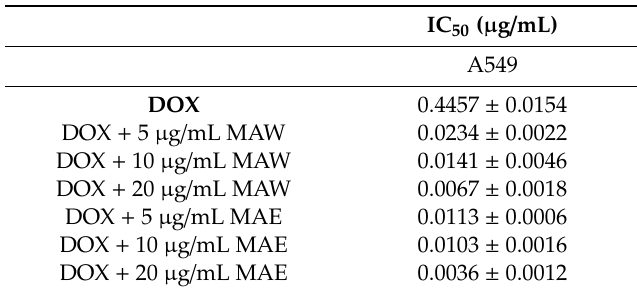
Table 1. Concentrations of doxorubicin alone or in combination with extracts that induced 50% decrease in cell survival after 72 h of treatment.